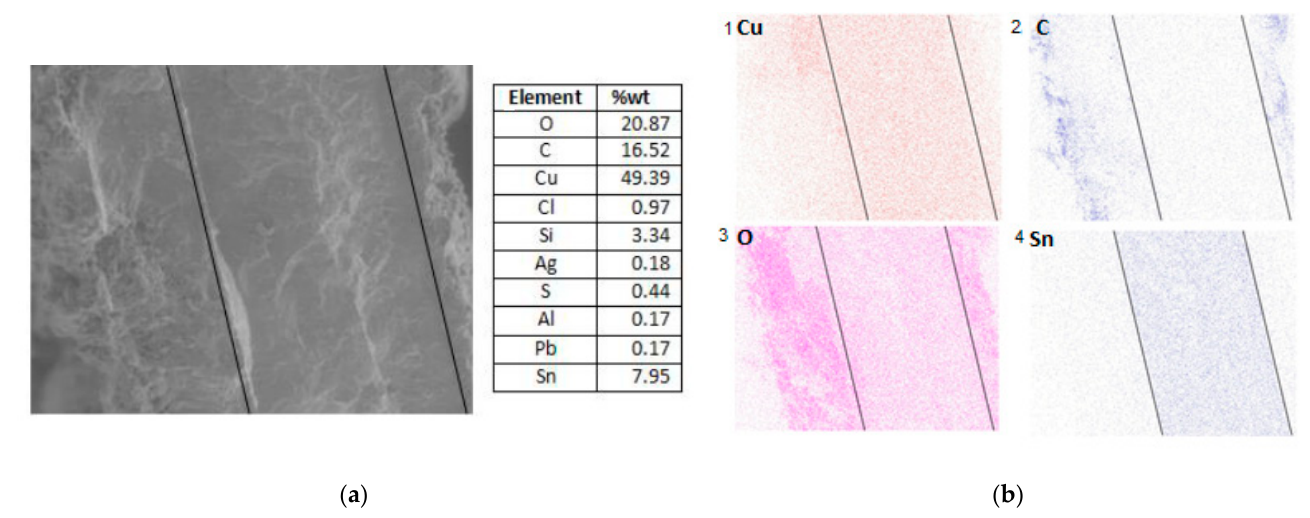
Figure 9. ( a ) SEM image and EDX analysis (600 × ) of the surface (corroded and bulk); ( b ) Concentration of Cu ( 1 ), C ( 2 ),